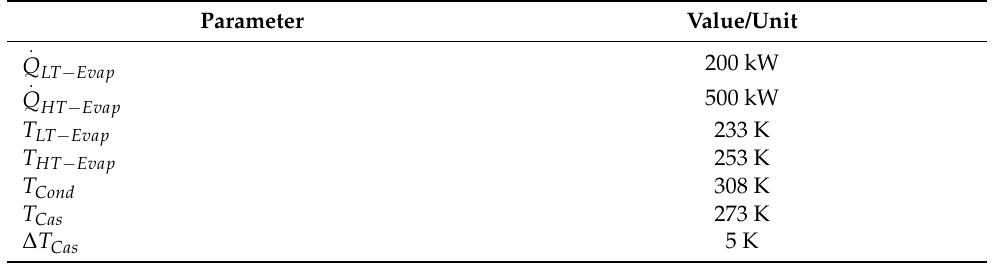
Table 2. Main system parameters used for